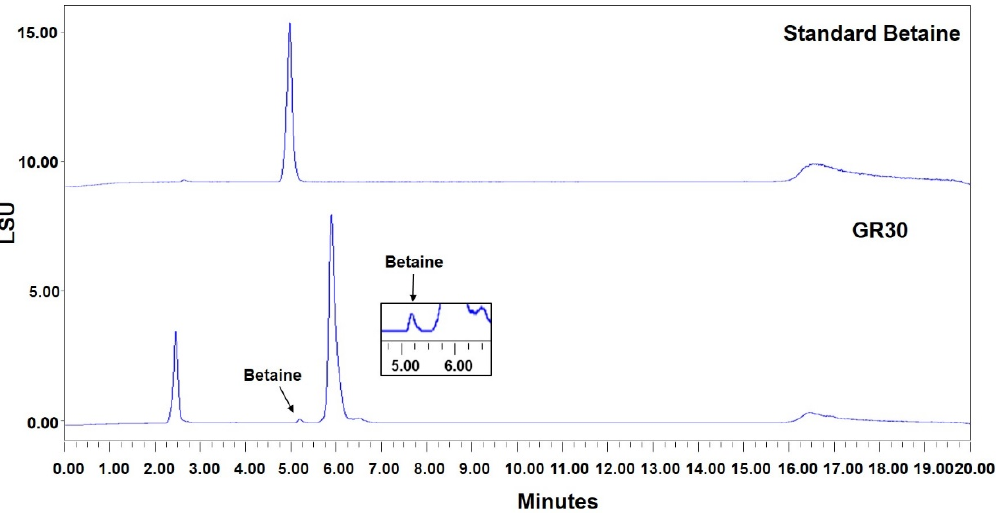
Figure 7. HPLC analysis for betaine in GR30. Betaine in the GR30 preparation was detected and quantified by HPLC system equipped with an ELSD detector. Authentic betaine was used as the reference.